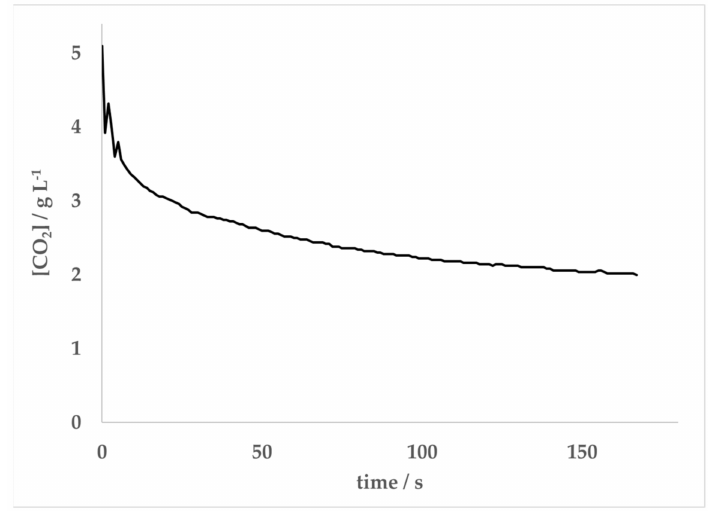
Figure 5. Time-dependent kinetics of CO 2 escape from 500 g of a solution containing 4.84 g L − 1 of CO 2 and 5% by mass ethanol at 20 ◦ C and P atm = 0.992 bar. The reaction was initiated by the addition of a single Mentos candy at t = 0 s.